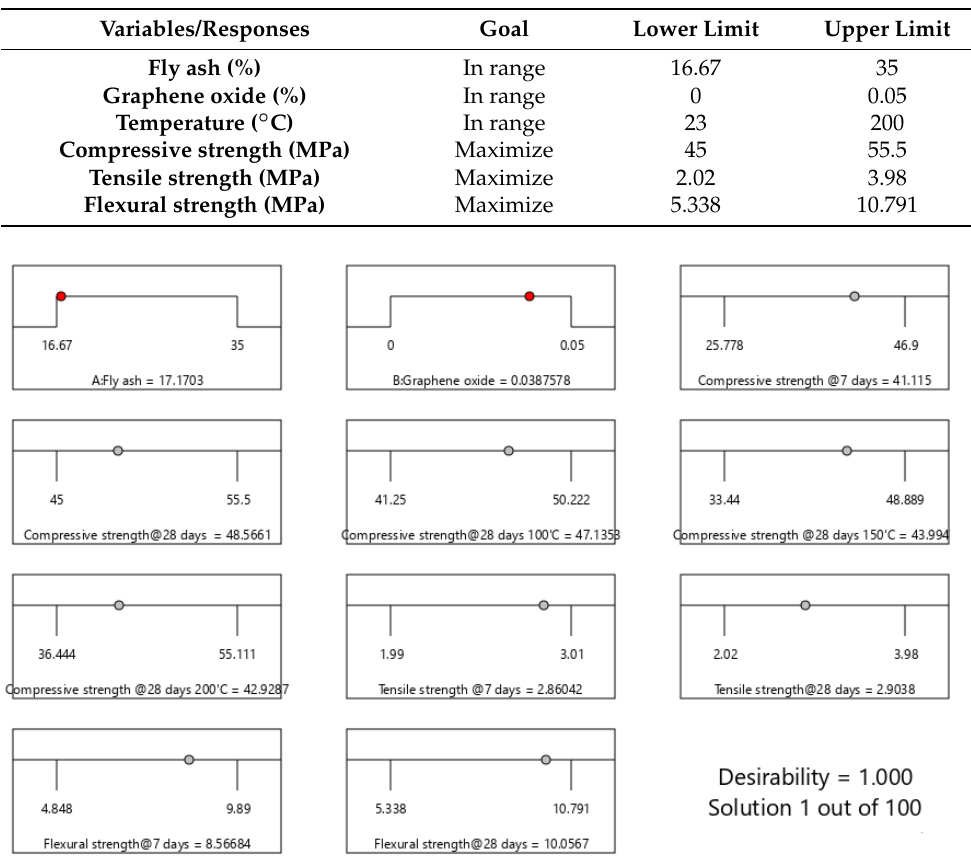
Figure 10 . Ramp view for optimization . Figure 10. Ramp view for